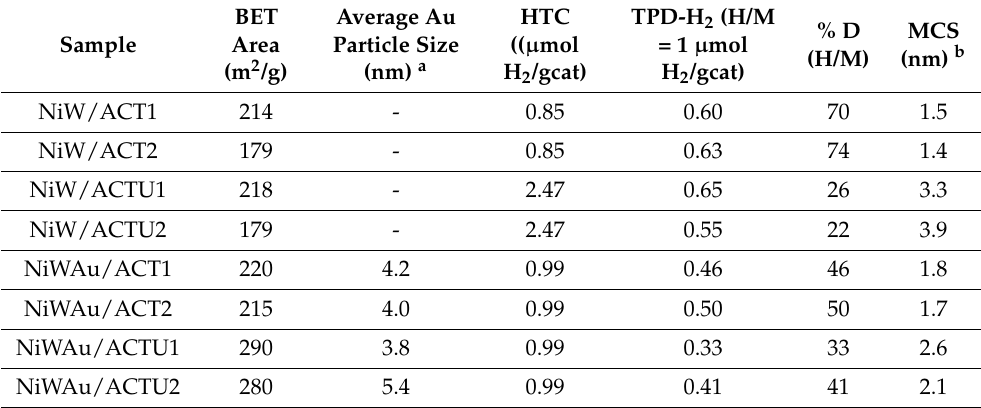
Table 6. Total dispersion (%) and metal crystallite sizes of the NiWAu/ACT nanomaterials by TPD-H 2